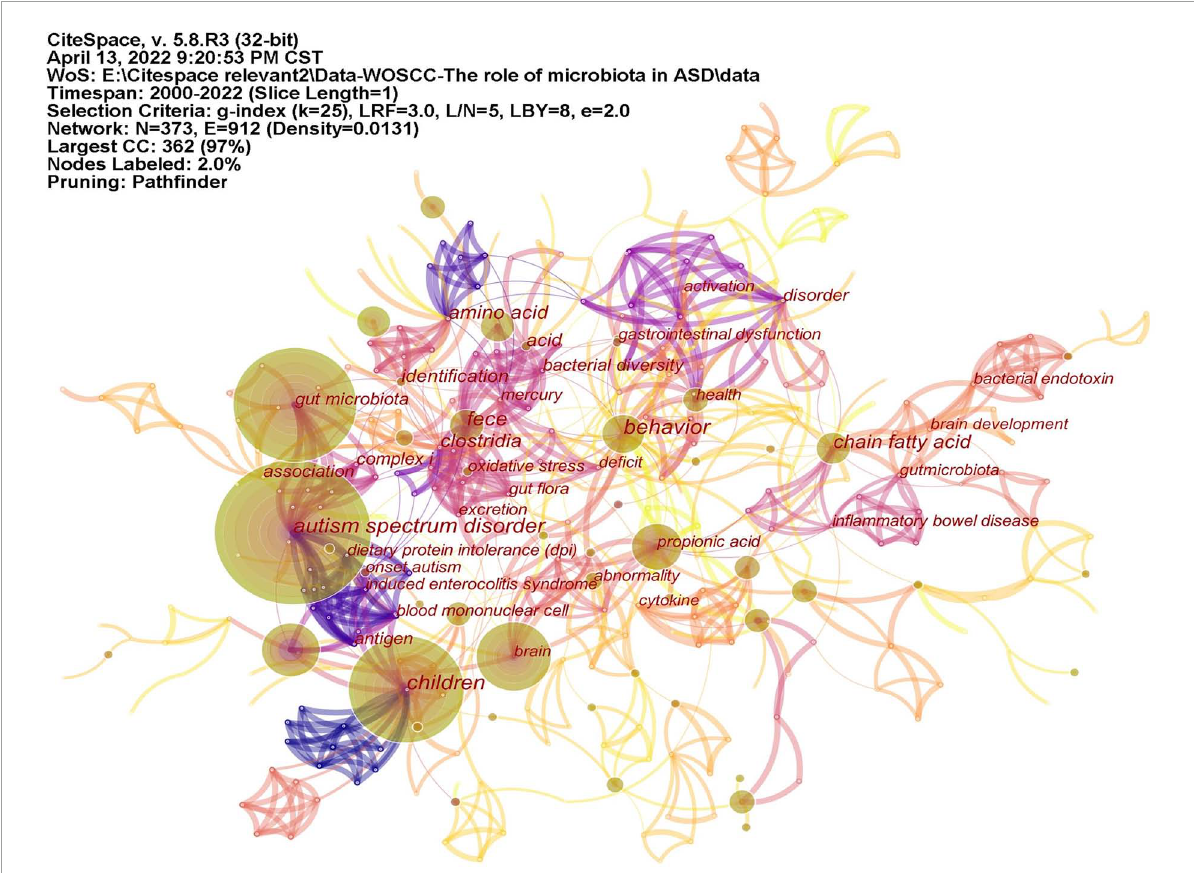
FIGURE7 The network of keywords on microbiota and ASD. The nodes represent keywords and the size of a node is proportional to the frequency of keyword occurrence.